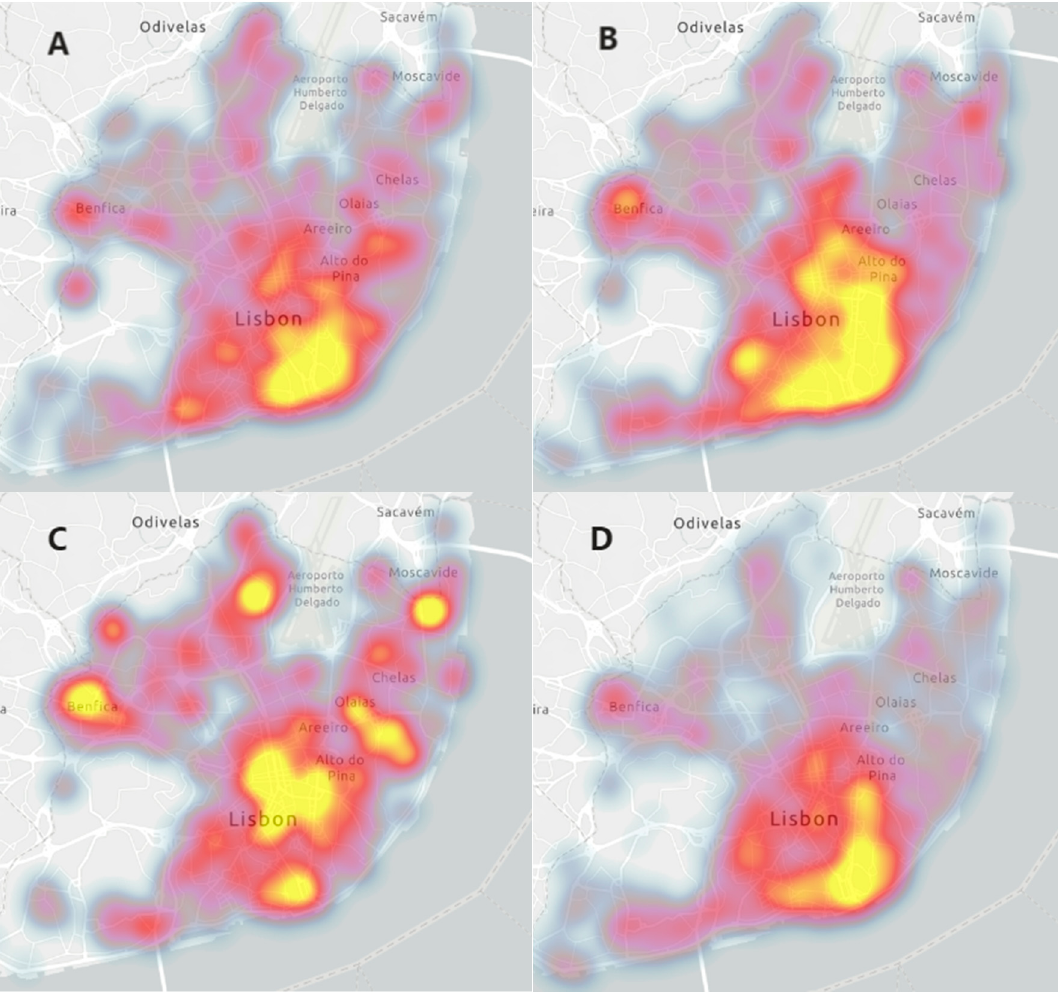
Figure 4. Heatmap—Spatial Distribution of each type of occurrence group. The A subfigure shows fire (building fires), B subfigure shows industrial–technological (gas leaks and suspicious situations). C subfigure shows accidents (with equipment or with elevators), and D subfigure shows infrastructure (floods and falls).